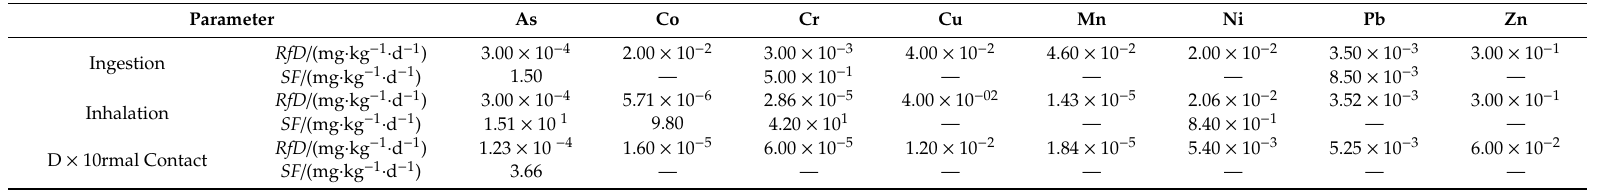
Table 2. Reference dose and slope factor of potentially harmful elements (PHEs) under di ff erent exposure pathways. Parameter As Co Cr